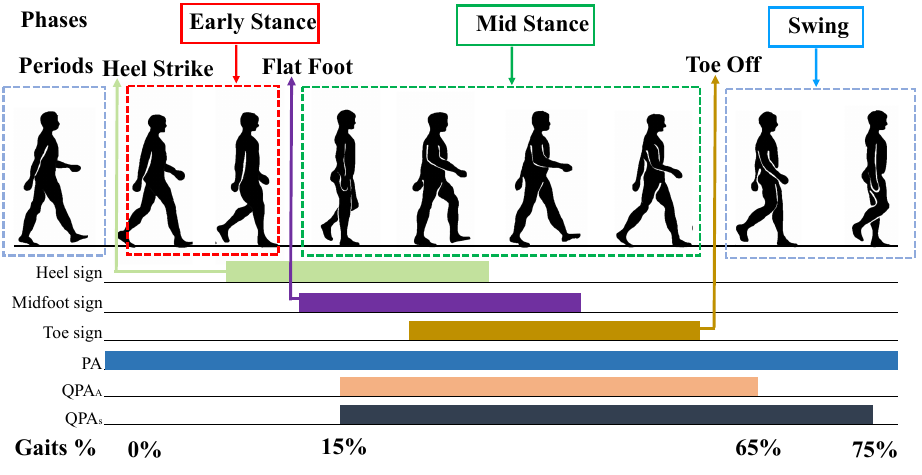
Figure 4. Human gait